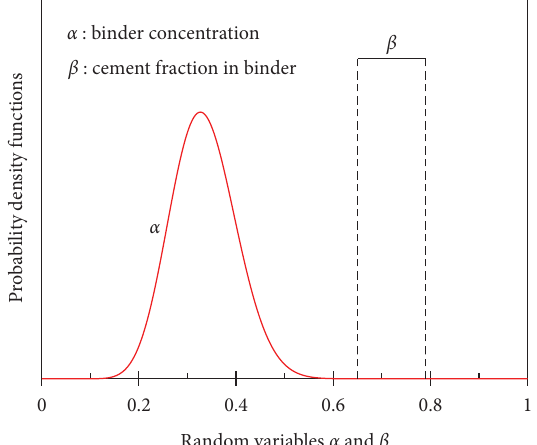
Figure 7: Probability density functions of α and β ( α, binder concentration; β, cement fraction in the binder). Table 2: Statistical parameters of reference case. Parameter Symbols Distribution type Mean COV Range Binder concentration α Beta distribution 0.33 0.2 0-1 Cement fraction in the binder β Uniform distribution — — 0.65–0.79